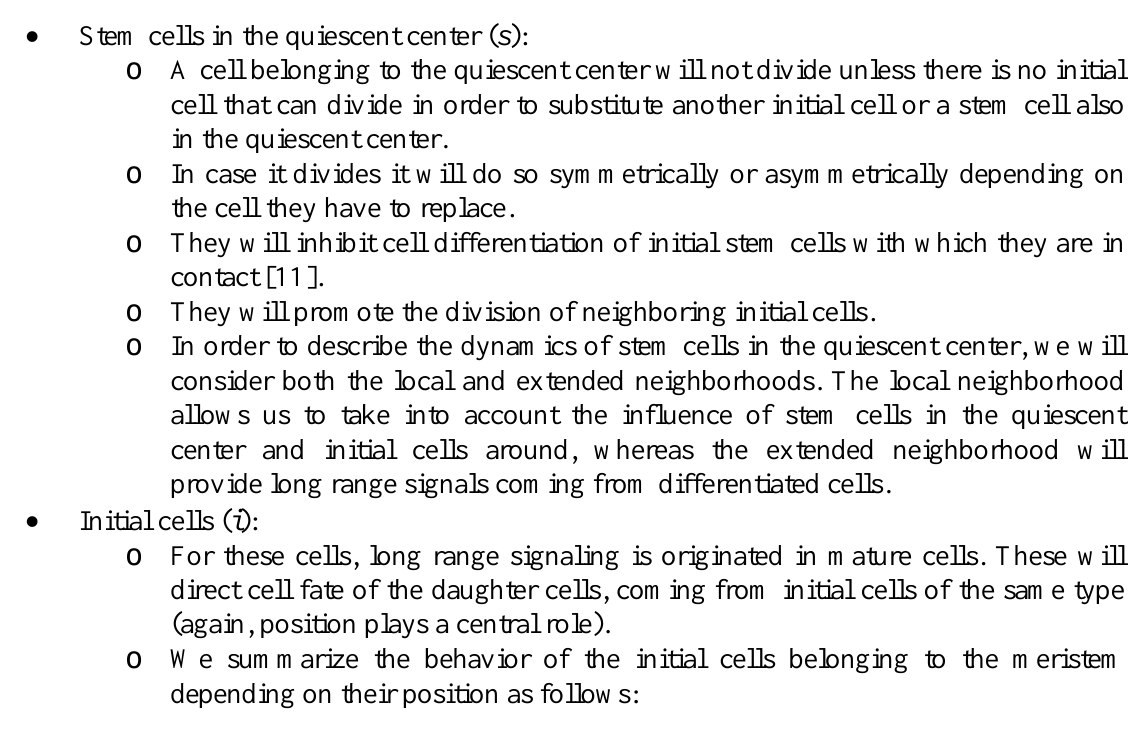
Table 1: Rules of transition for initials